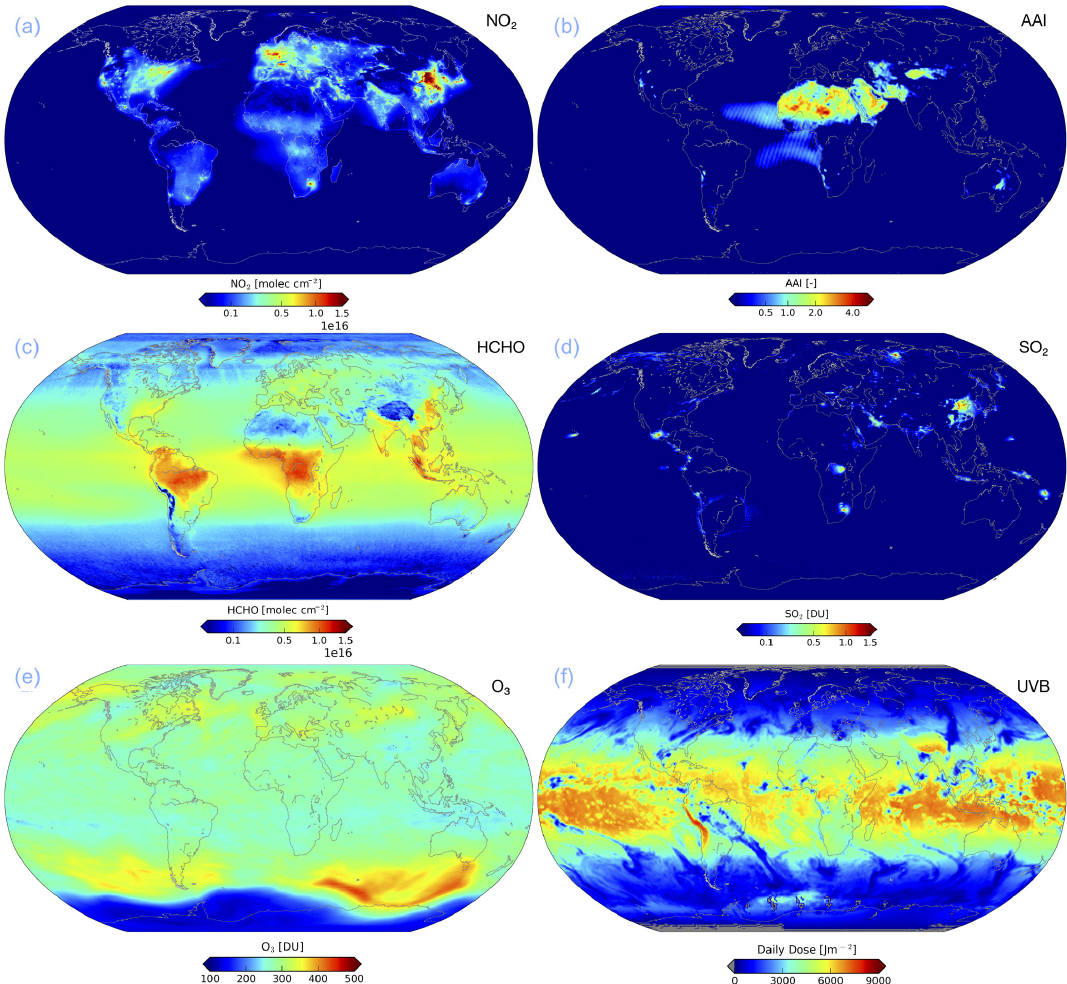
Figure 1. OMI mission averages (2004–2016) for NO 2 (a) , absorbing aerosol index (AAI; b ), HCHO (c) , and SO 2 (d) . Total ozone column (O 3 ; e) and surface UVB amount (f) are shown for 24 September 2006, the day with a record size ozone